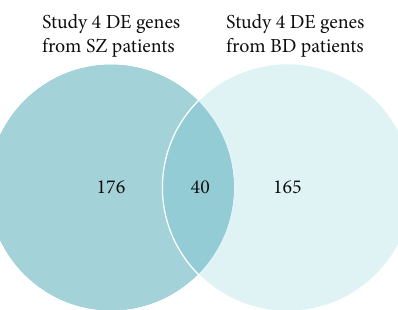
F 3: Venn diagram drawn based on DE genes in SZ and BD patients compared with controls of the fourth study from Brodmann’s Area 46 (attention and working memory functions). e common DE genes are represented by the intersection of the two circles.